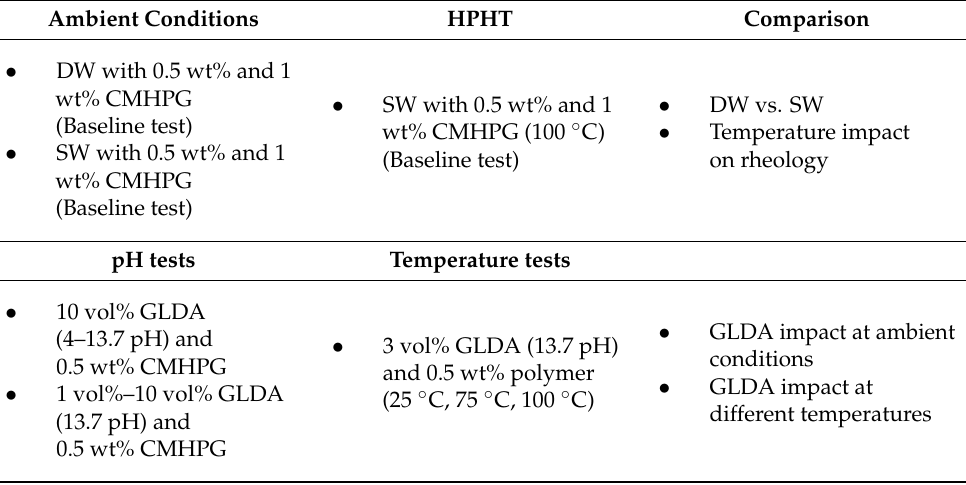
Table 2. Rheology experiments performed at standard and HPHT